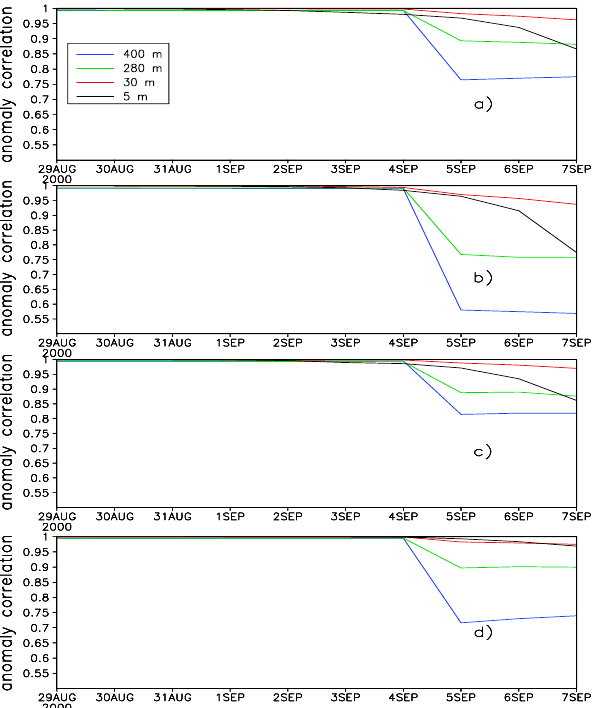
Fig. 11. Anomaly correlation (Eq. 2) of forecast and analysis for (a) the whole Mediterranean Sea; (b) the Algerian Basin; (c) the Tyrrhenian Basin; (d) the Ionian Sea. The black curves correspond to the 5 m depth, the red to 30 m, the green to 280 m and the blue to 400